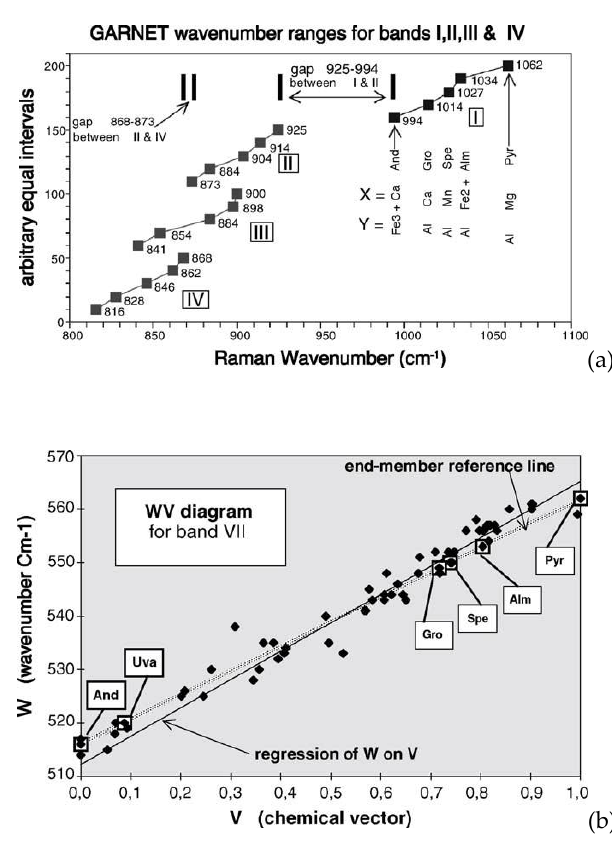
Figure 8. Experimental data determined by Smith et al. and the application of RAMANITA method: ( a ) plot of wavenumbers of bands I–IV for the garnet system Pyr–Alm–Spe–Gro–And–Uva; ( b ) the WV diagram for band VII in the Pyr–Alm–Spe–Gro–And–Uva garnet system. (Reproduced from [39] with the permission of Elsevier, copyright 2005).